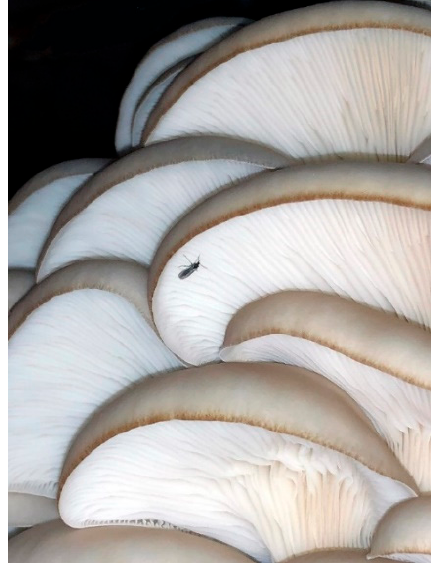
Figure 1. Adult fungus gnat, Lycoriella sp., resting on the gills of an oyster mushroom, P. ostreatus .